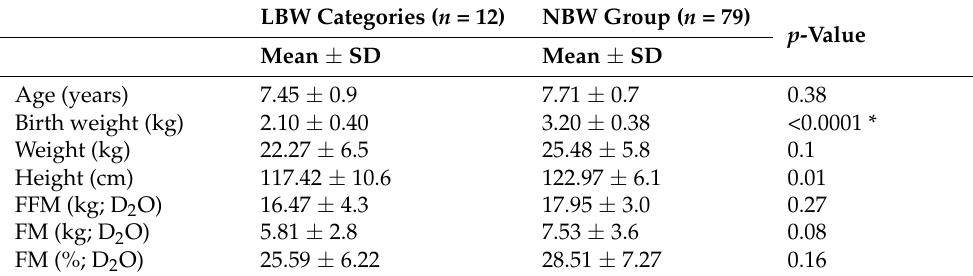
Table 3. Participants’ body composition according to BW groups.